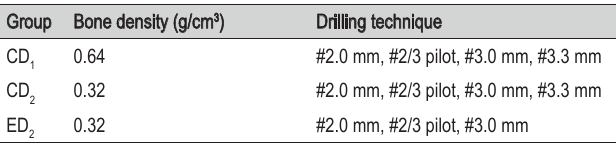
Table 1 - The combination of the drilling technique and bone density Group Bone density (g/cm 3 ) Drilling technique